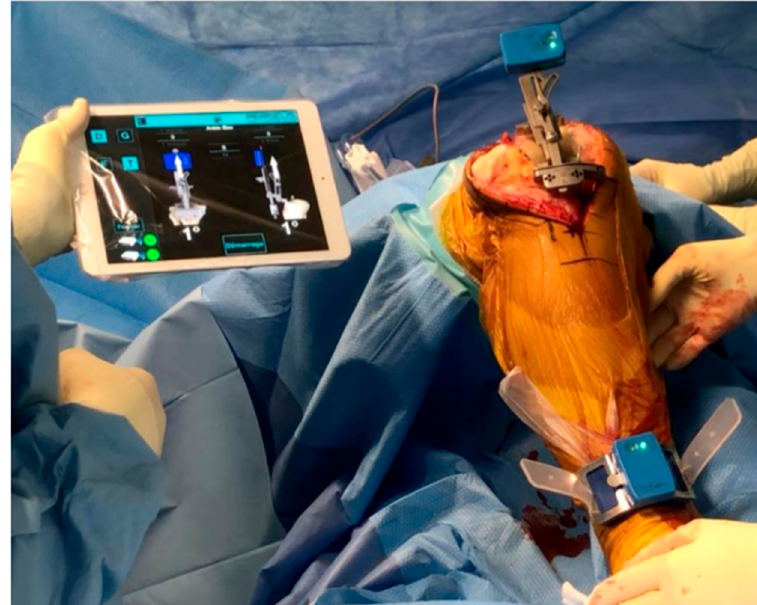
Figure 1. Navigation setup with software and sensors.